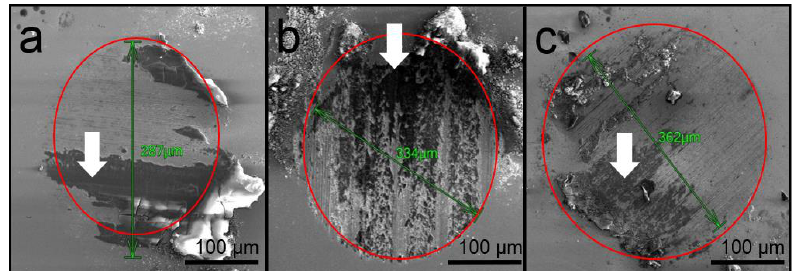
Figure 6. Wear width and transfer layer of 0.3% NGCC at the wear distance of ( a ) 10, ( b ) 15, and ( c ) 20 m.